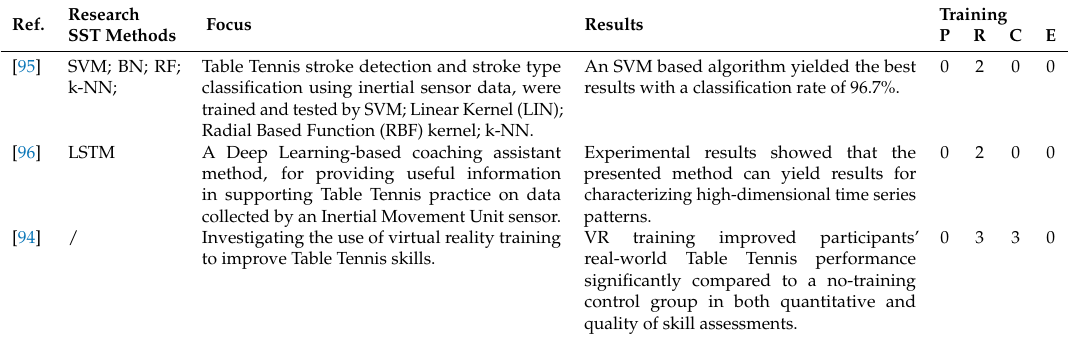
Table 13. Identified studies in the domain of table